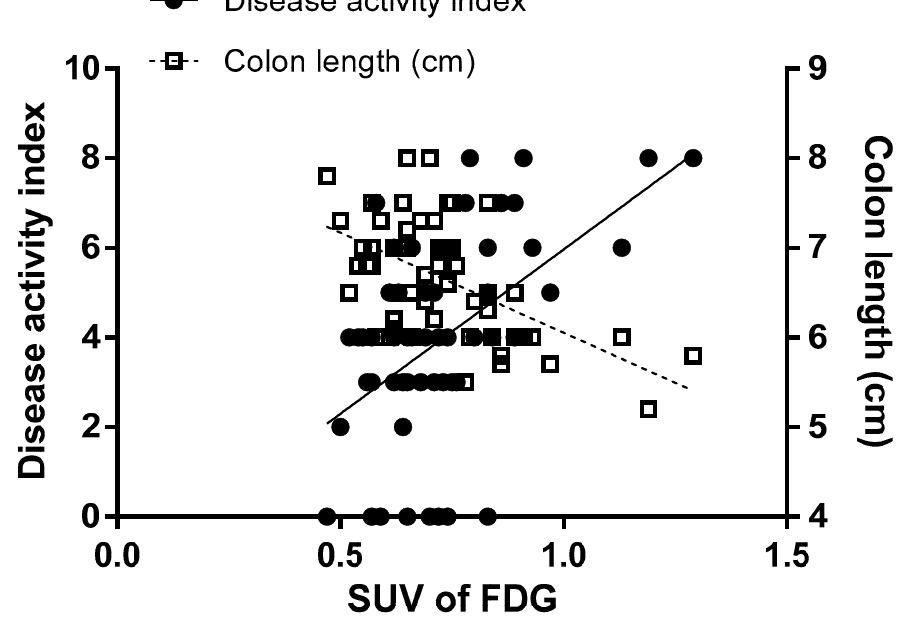
Figure 3. Scatter plot of the disease activity index (DAI) and colon length against the standard uptake value (SUV) for FDG. The Pearson correlation coefficient between the SUV for FDG and DAI was r = 0.5248 and p < 0.0001, and that between the SUV for the FDG and colon length was r = − 0.5548 and p < 0.0001.